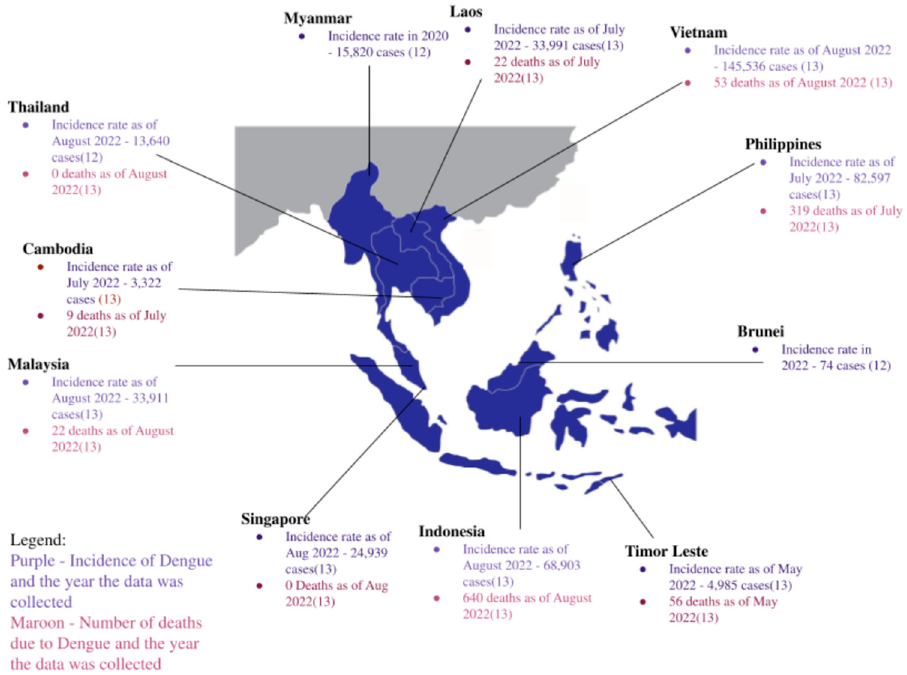
Figure 1. Map of geographical Southeast Asia. The incidence of dengue in each country, the year the data were collected, and the number of mortalities due to dengue [12-14].